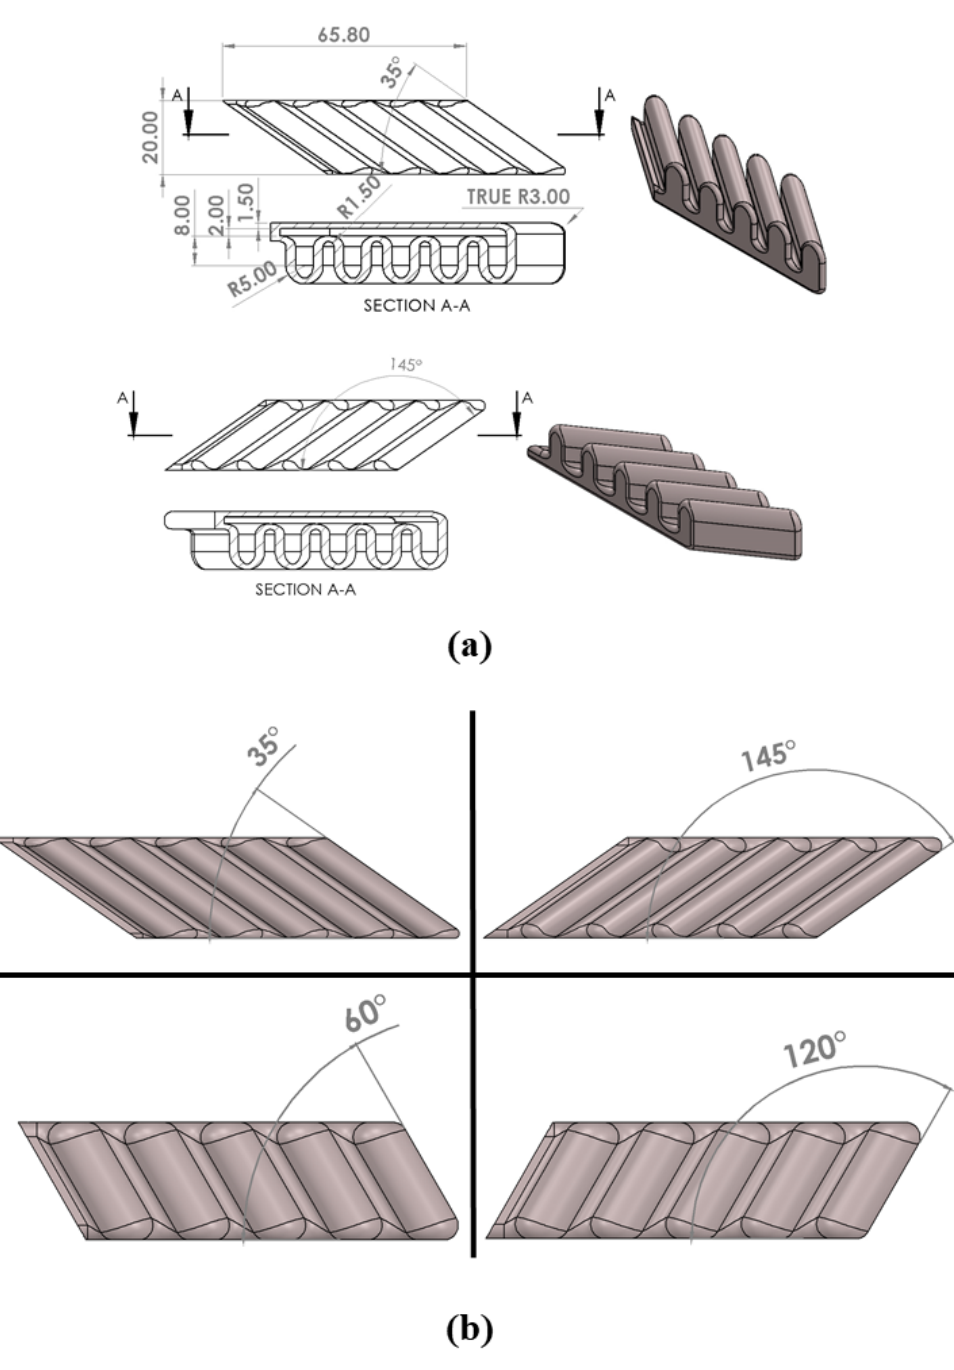
Figure 2. 3D Design and geometrical dimensions of the SPA for orientation angles bigger and smaller than 90 ◦ . ( a ) Detailed CAD design with dimensions. ( b ) SPAs θ = [35 ◦ , 60 ◦ , 120 ◦ , 145 ◦ ] demonstration that shows the orientation angle